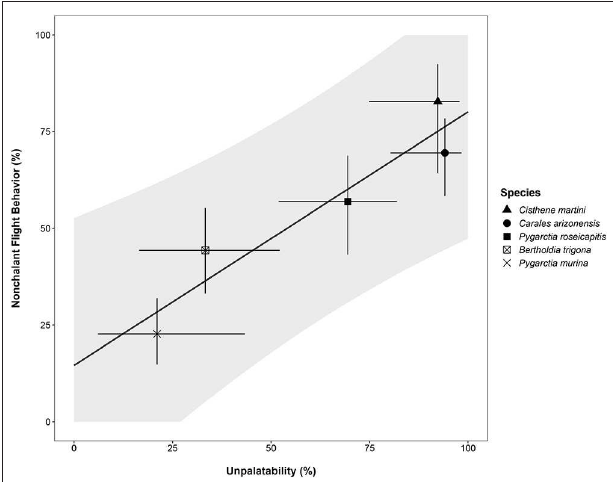
FIGURE 2 | Plot of linear model of nonchalance. Gray ribbon represents the 95% prediction interval for the linear model relative nonchalant flight behavior and unpalatability ( Table 3 ). For a species with a given Unpalatability, Nonchalance is expected to fall within these intervals in 95% of cases. For each species, point estimates (unique symbols) and 95% confidence intervals (line segments) for the binomial probabilities for both nonchalance and unpalatability are plotted.